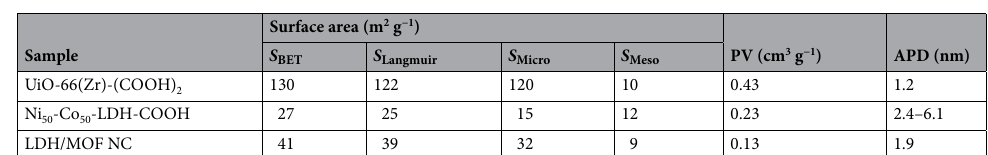
Table 2. The results of BET and BJH analyses for the synthesized samples ( S BET , S Langmuir , and S Micro represent surface area according to the BET, Langmuir, and t-plot method, respectively. S Meso and S Micro demonstrate micropore surface area and mesopore surface area, respectively: S Meso = S BET − S Micro . PV and APD are pore volume and average pore diameters).